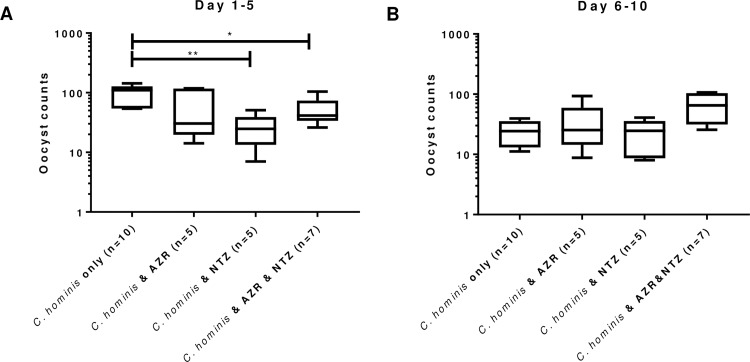
Accumulated counts of oocyst excretion in feces of TU502-challenged piglets treated with either, AZR, NTZ or AZR+NTZ, as compared with an untreated infected group.There was a notable contrasting in the level of oocyst excretion between days 1–5 (A) and day 6–10 (B) of treatment, as shown with box-and-whiskers plot (min to max). Mann-Whitney test was conducted using GraphPad Prism 7.01. *p<0.05, **p<0.01.